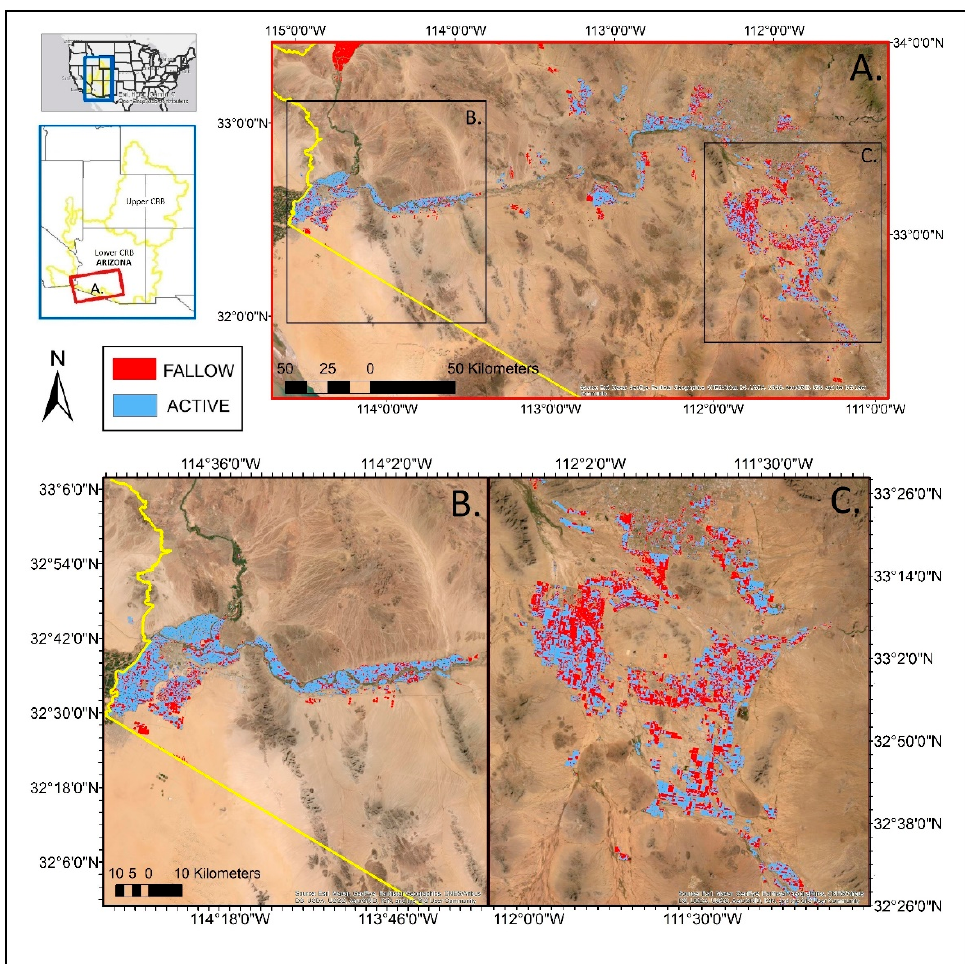
Figure 1. The study regions in 2017 ( A ), including the lower Colorado river planning (LCRP) area ( B ), and the Pinal and Phoenix active management areas (PPAMA) ( C ). Base map shows the 2017 fallow-land algorithm based on neighborhood and temporal anomalies (FANTA) active (blue) and fallow (red) cropland classification. Inset map in upper-left outlines in yellow the upper and lower Colorado River Basin (CRB) and in red the region of interest for this study.